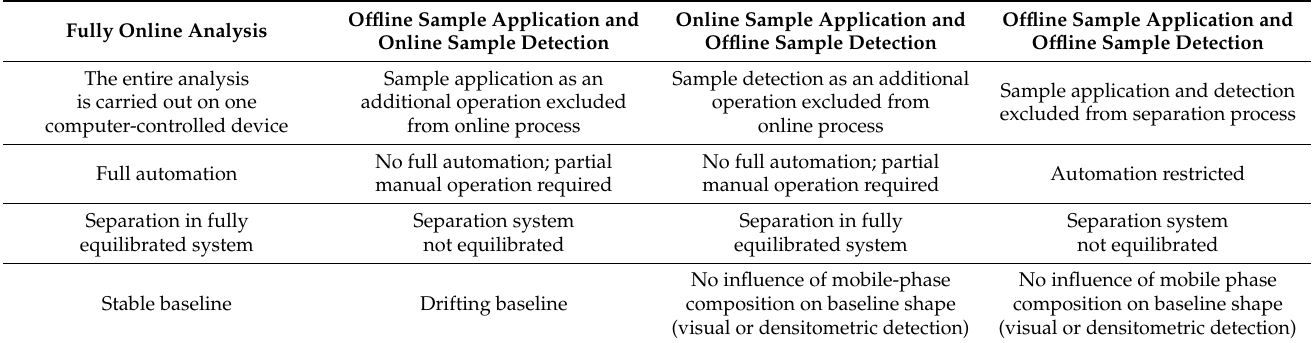
Table 2. Variants of conducting the analysis with the HPLEC equipment and their